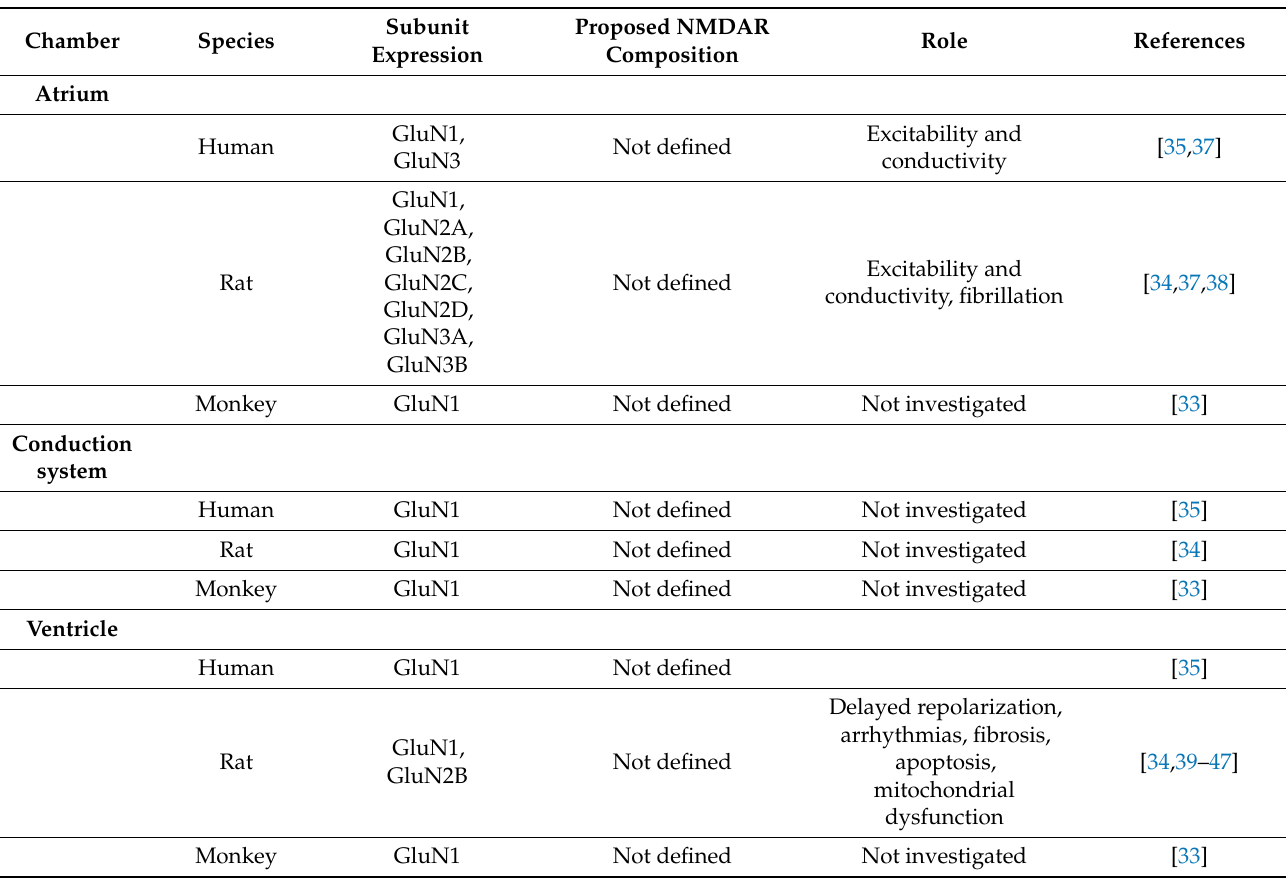
Table 1. NMDARs in the